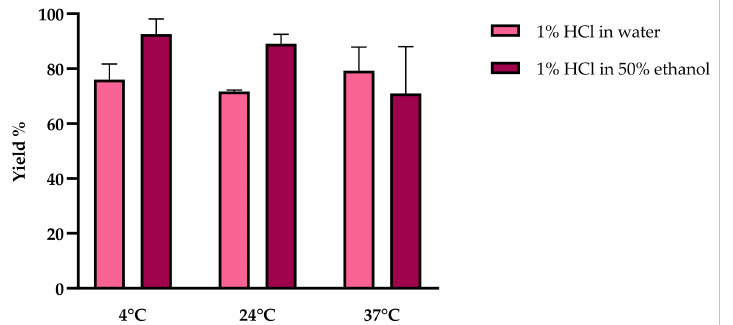
Figure 3. Anthocyanin yields were obtained by extraction with different solvents (water or 50% ethanol, each containing 1% HCl) at different incubation temperatures (4, 24, and 37 ◦ C). Values are percentages (yield %) relative to the gold-standard method. Data are means ± SD